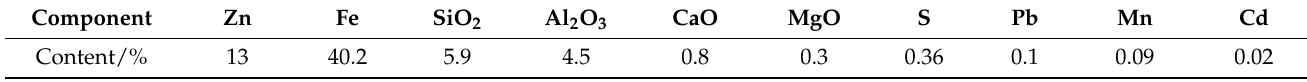
Table 1. Chemical components of Tongkeng